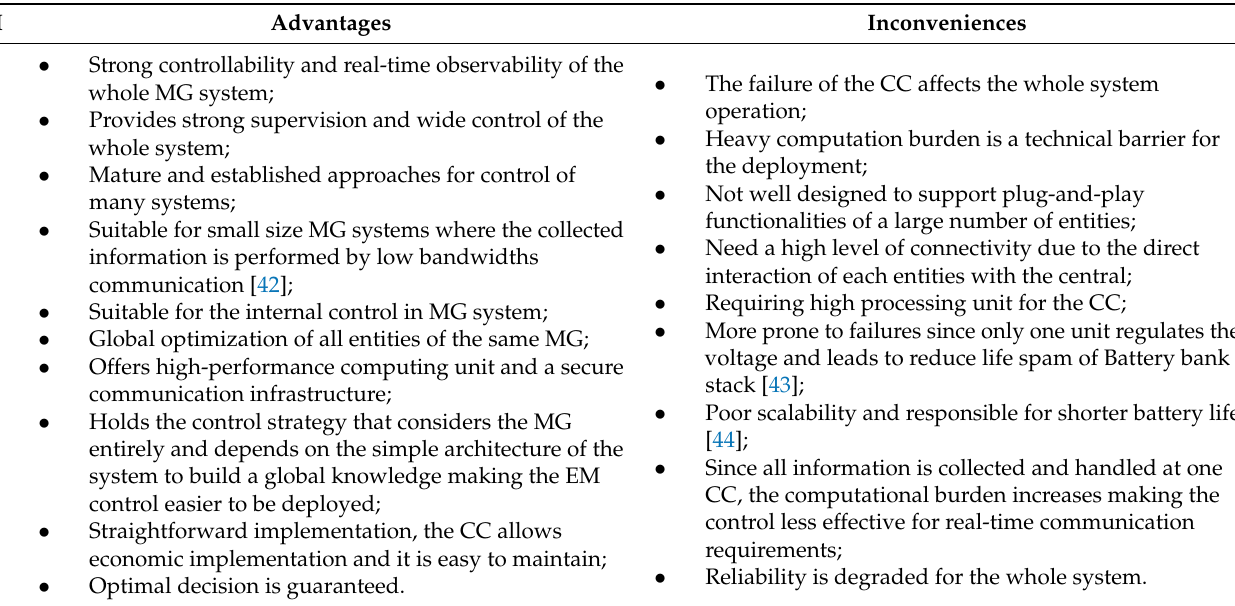
Table 3. Control architectures for hybrid system, advantages and